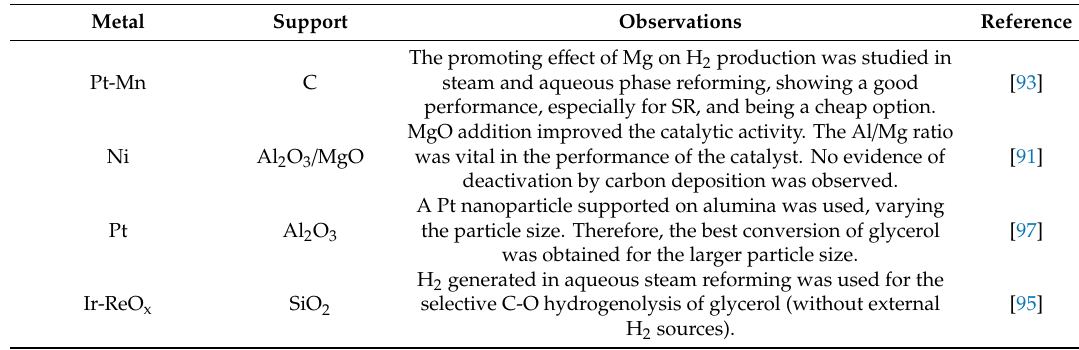
Table 4. Catalysts recently used in glycerol aqueous phase